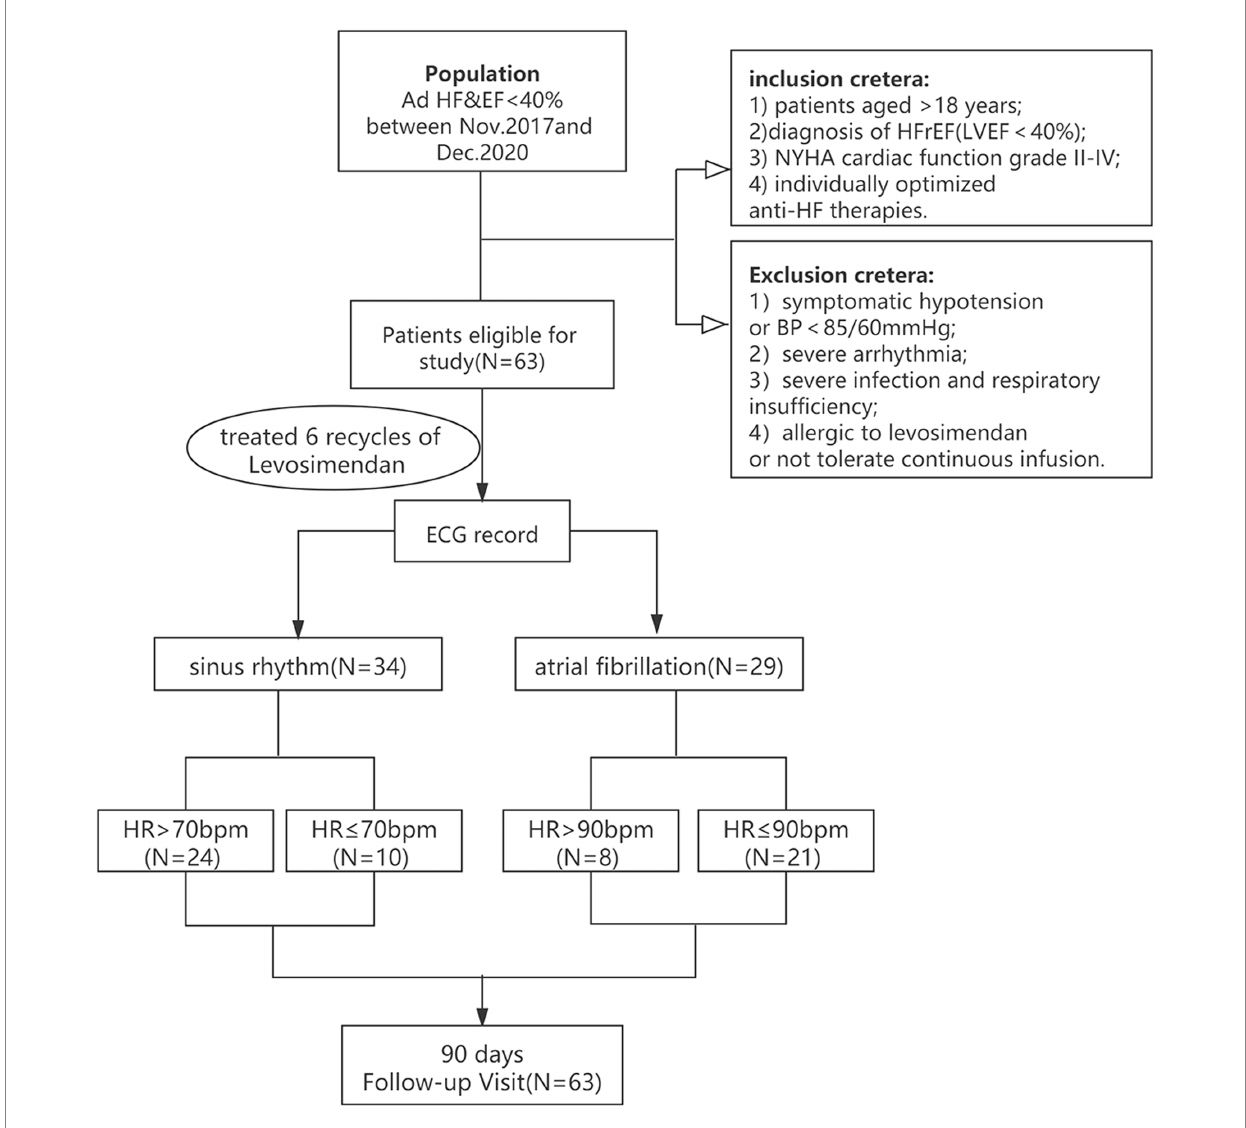
FIGURE 1 The flowchart for studying the therapeutic effect of levosimendan on advanced HFrEF patients with sinus rhythm or atrial